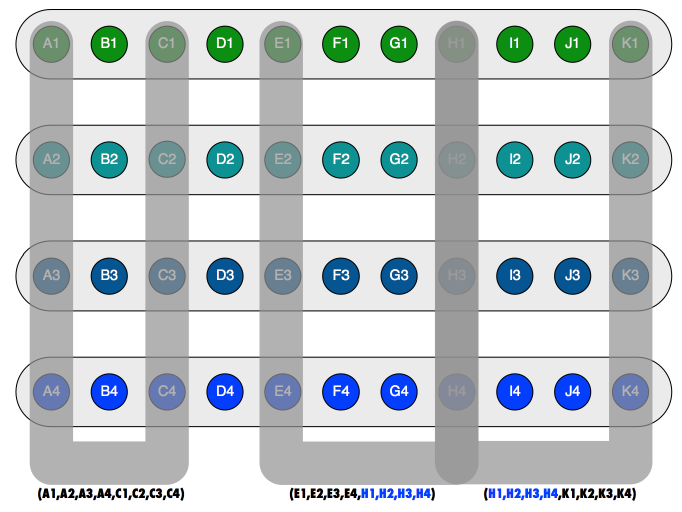
Figure 1. Illustrative example of three MultiAspect Graphs (MAG)